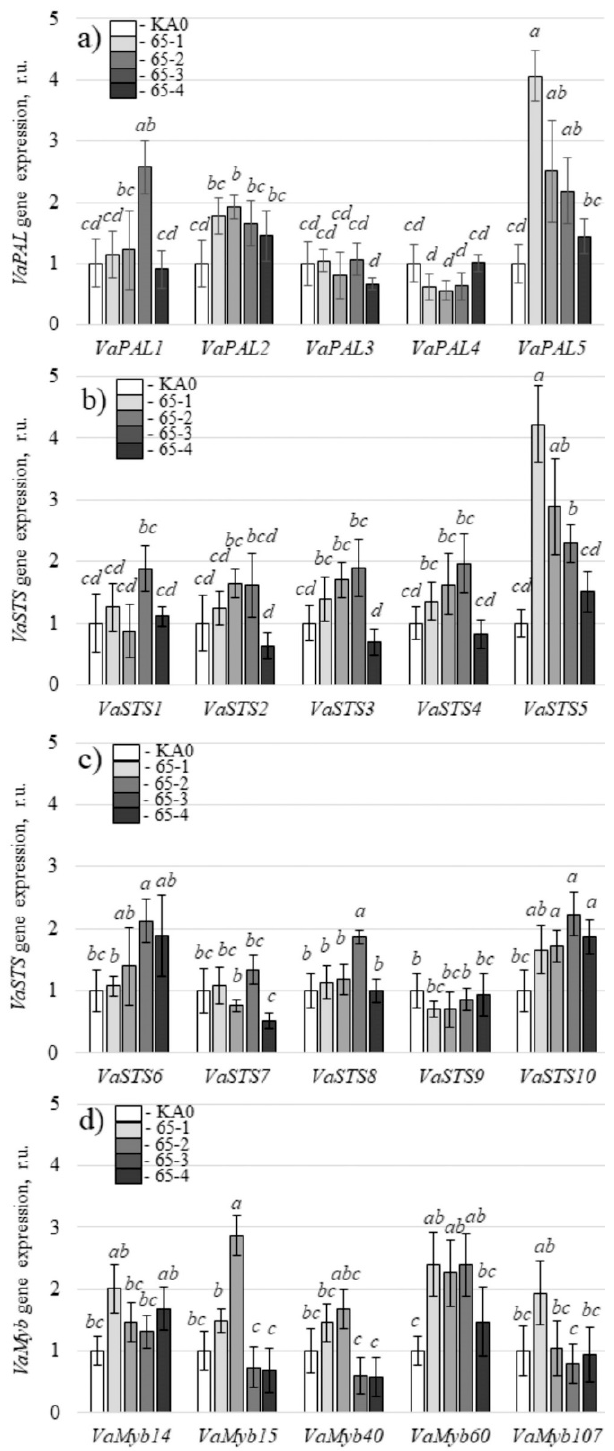
Figure 3. Quantification the VaPAL1-5 ( a ) and VaSTS1-5 ( b ), VaSTS6-10 ( c ), and VaMyb14, 15, 40, 60 , and 107 ( d ) gene expression in the VaCML65 -transgenic cell lines of Vitis amurensis performed by quantitative PCR (qRT-PCR). RNA was extracted from the vector control (KA0), VaCML65-1 , -2 , -3 , and -4- transformed cell lines of V. amurensis . Means on each figure followed by the same letter were not different using one-way analysis of variance (ANOVA), followed by the Tukey HSD multiple comparison test (two independent experiments with eight technical replicates). p < 0.05 was considered to be statistically significant. n.d.—not detected.